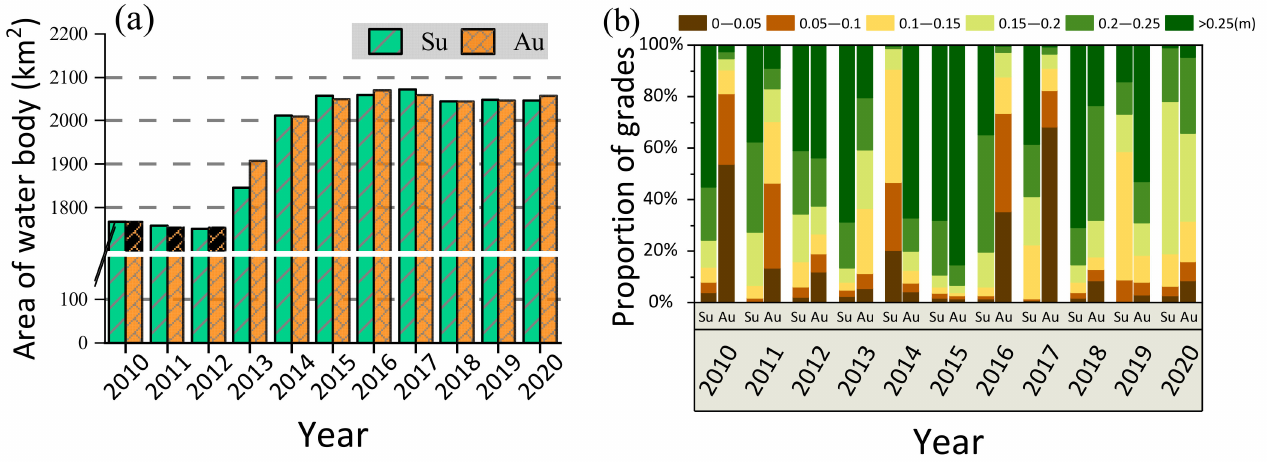
Figure 6. Statistical values of the area, including ( a ) area of the water body; ( b ) proportion of grades. Notes: Su indicates summer; Au indicates